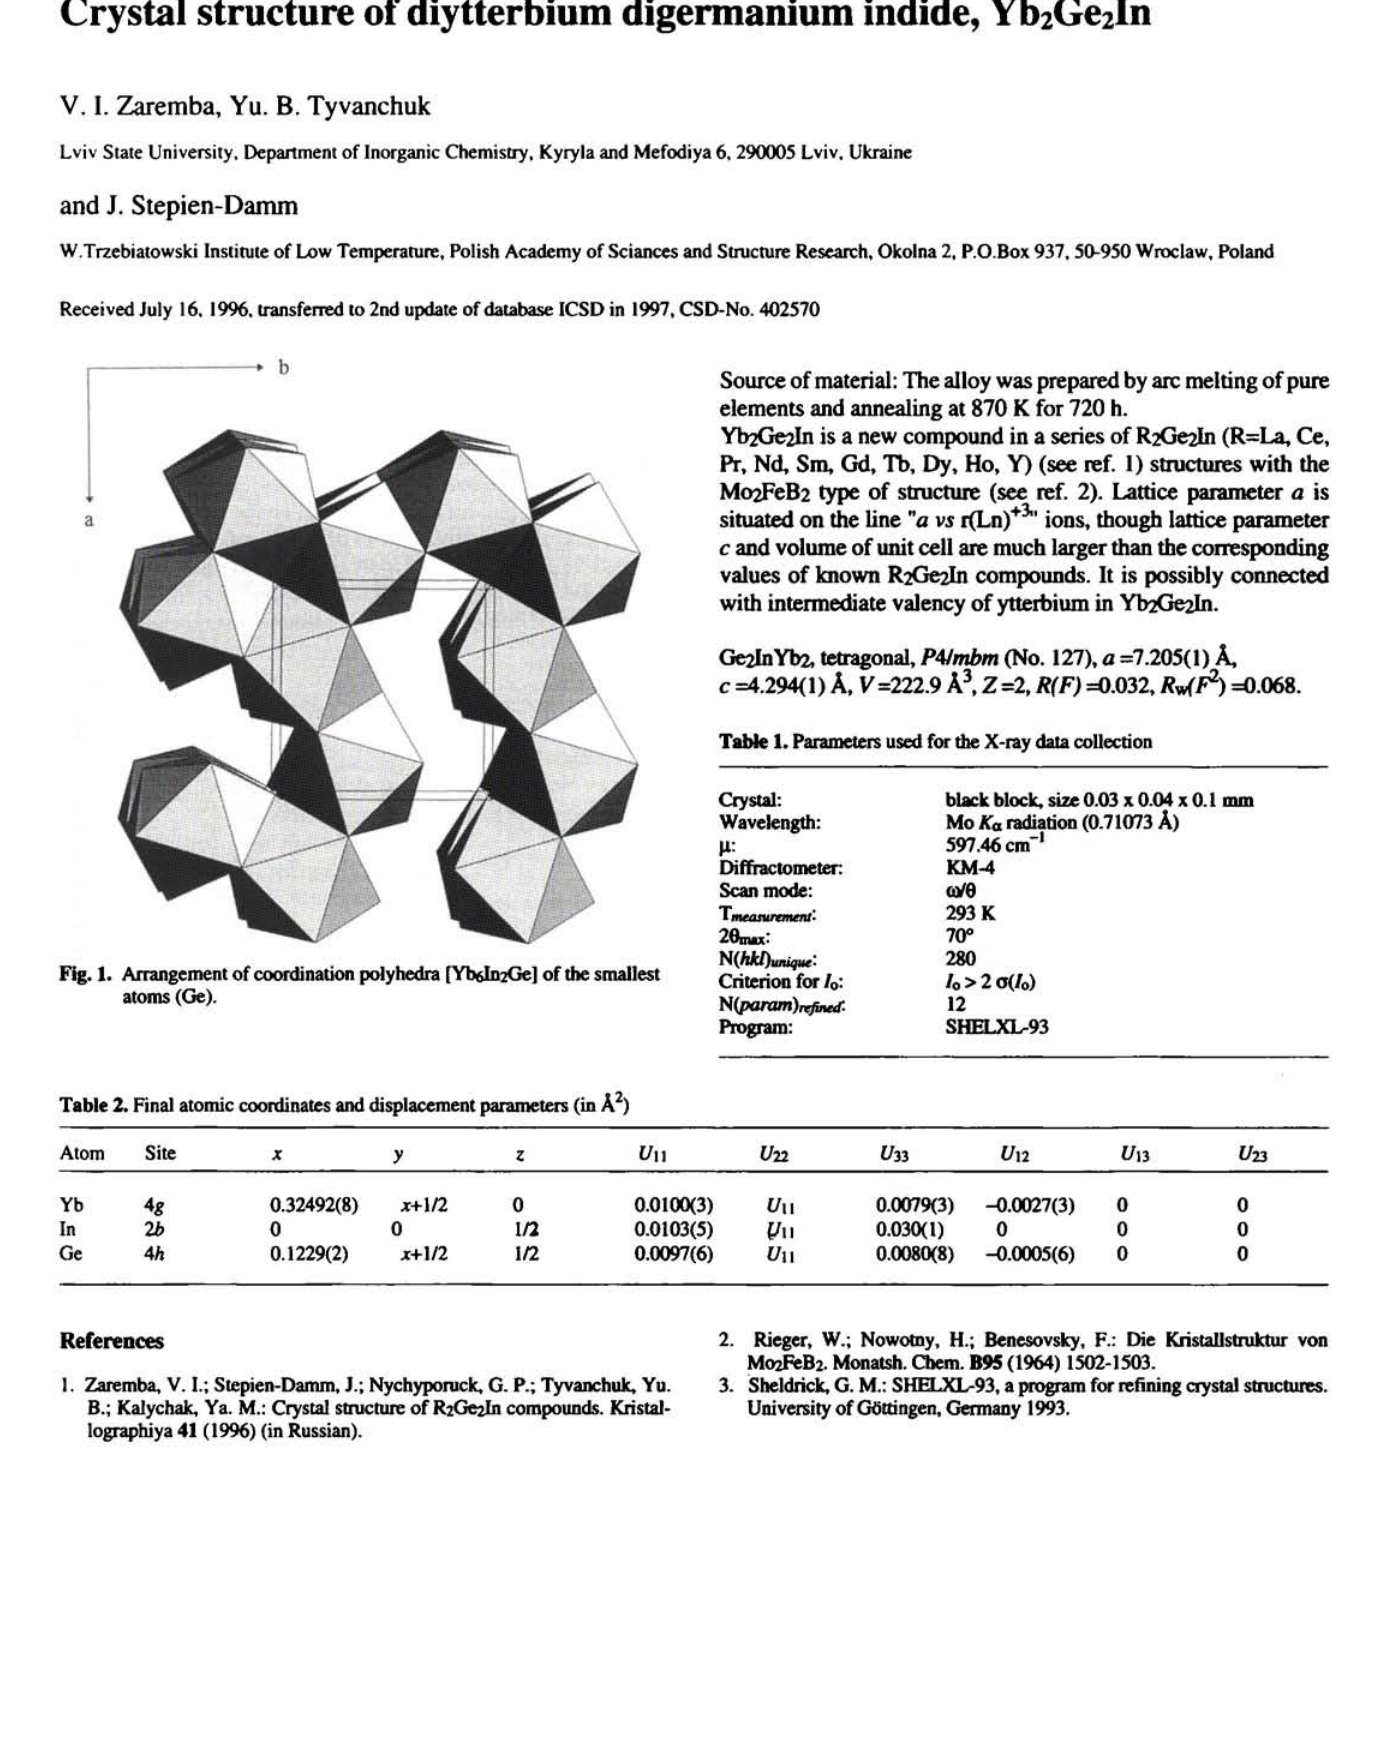
Table 2. Final atomic coordinates and displacement parameters (in À 2 )